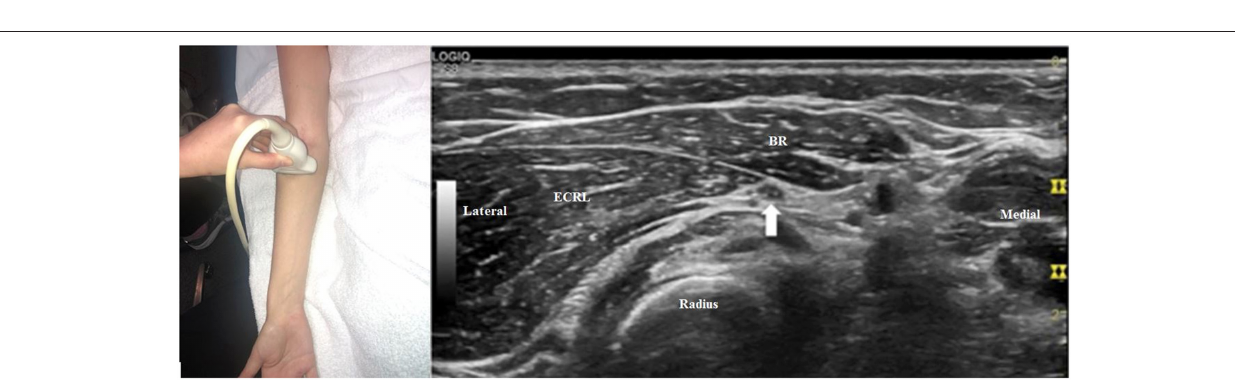
Frontiers in Neurology |